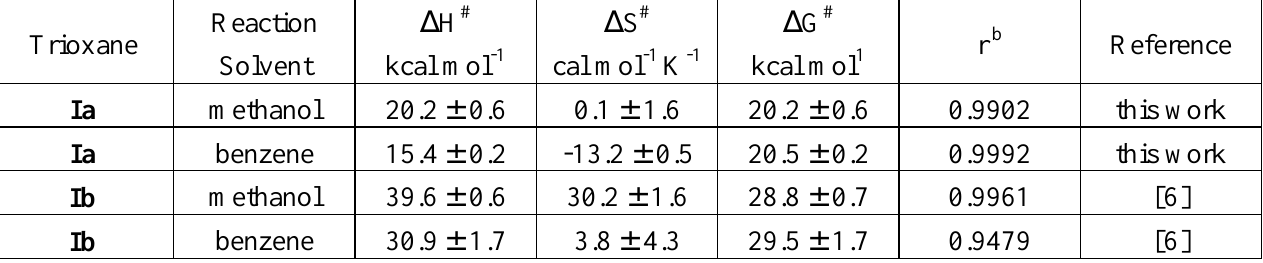
Table II. Activation Parameters a for the Unimolecular Thermolysis in Solution of Substituted